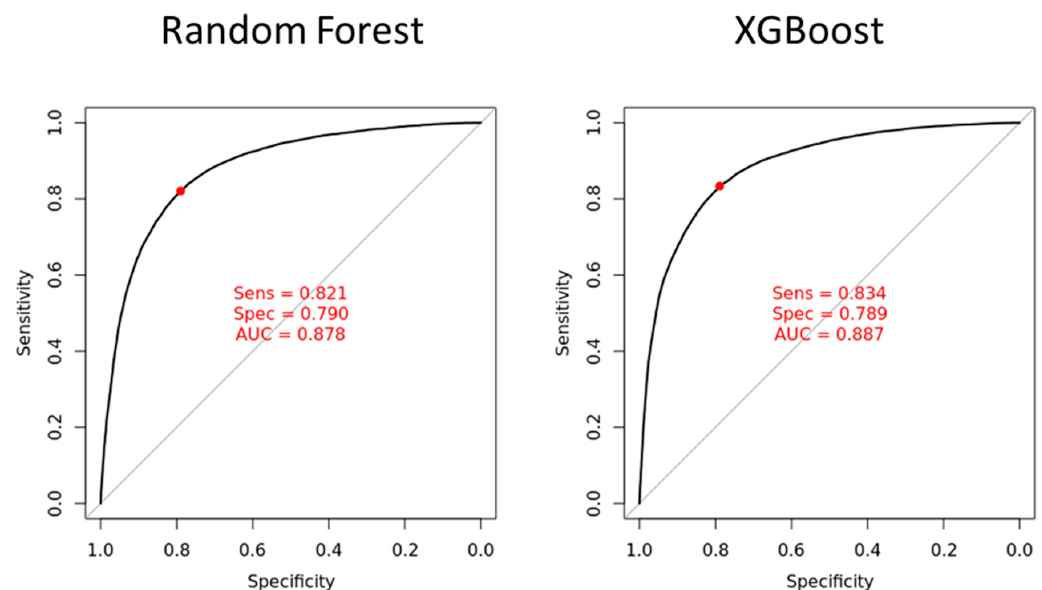
Figure 2. The ROC curves from four prediction models in the validation cohort. The ROC curves ( x -axis = specificity and y -axis = sensitivity) and AUCs were calculated using the validation set. The operating point (red dot) was selected based on the maximum of Youden’s index in the validation cohort, and was used for calculating the corresponding sensitivity and specificity. Sens, sensitivity; Spec, specificity; AUC, area under receiver operating characteristic curve.